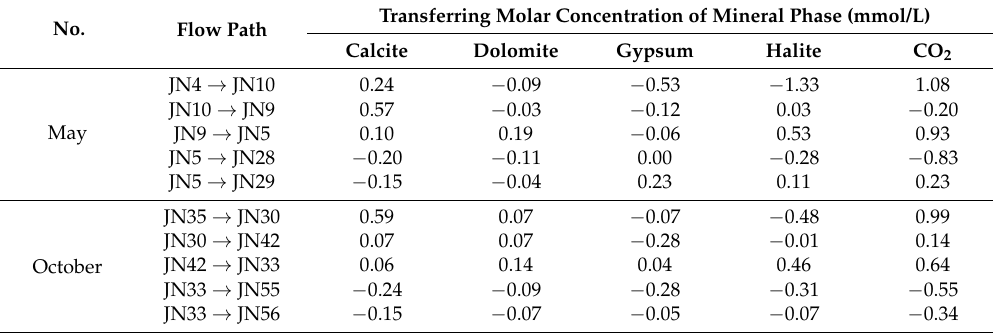
Table 5. The simulation results for the inverse hydrogeochemical model. Transferring Molar Concentration of Mineral Phase (mmol/L) No. Flow Path Calcite Dolomite